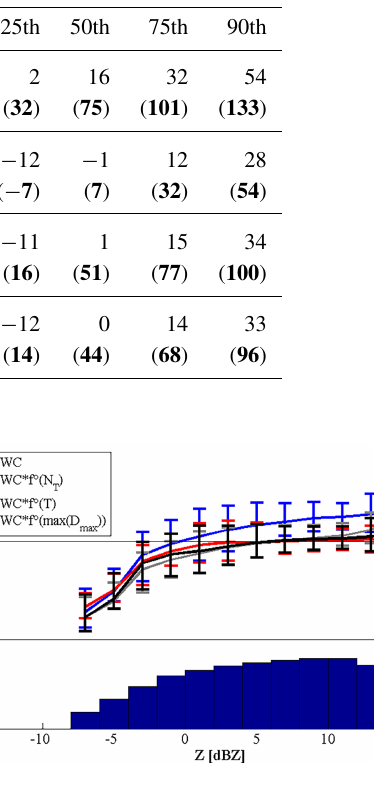
Figure 7. Same as Fig. 3 but represented as a function of radar reflectivity factors Z on the x